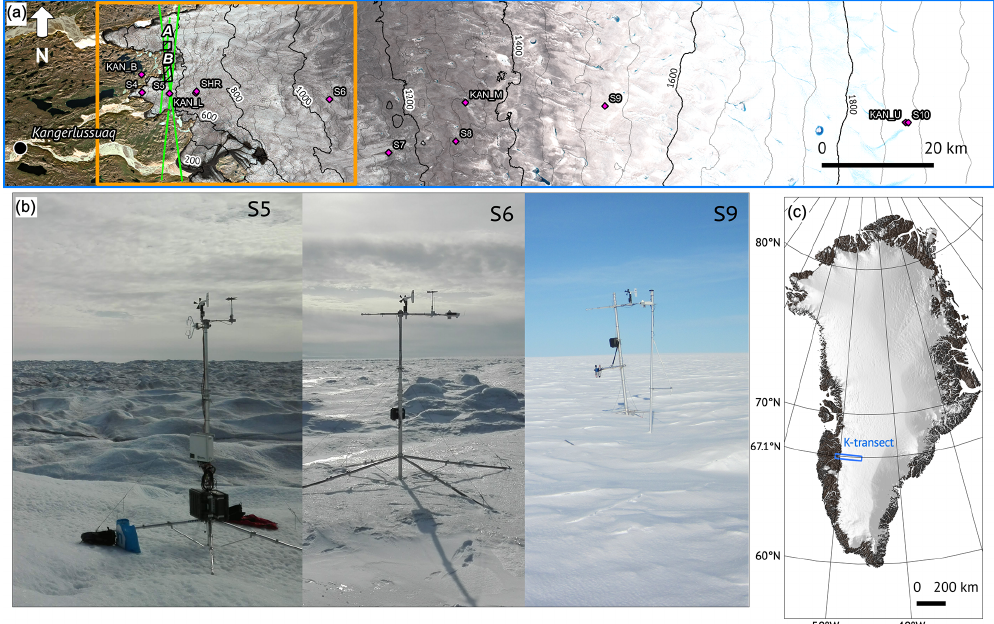
Figure 1. (a) Map of the K-transect, with the location of the automatic weather stations and mass balance sites indicated by the pink diamonds. The black boxes A and B delineate the areas mapped by UAV photogrammetry. The large black box indicates the area covered in Figs. 6 and 9. The background image was taken by the MSI instrument (ESA, Sentinel-2) on 12 August 2019. Pixel intensity is manually adjusted over the ice sheet for increased contrast. The green solid lines denote the ICESat-2 laser tracks that are compared to the UAV surveys (Table 2). (b) Sites S5 (6 September 2019), S6 (6 September 2019), and S9 (3 September 2019) taken during the yearly maintenance. Note that no data from the AWS shown at S9 are used in this study. (c) Location of the K-transect on the Greenland Ice